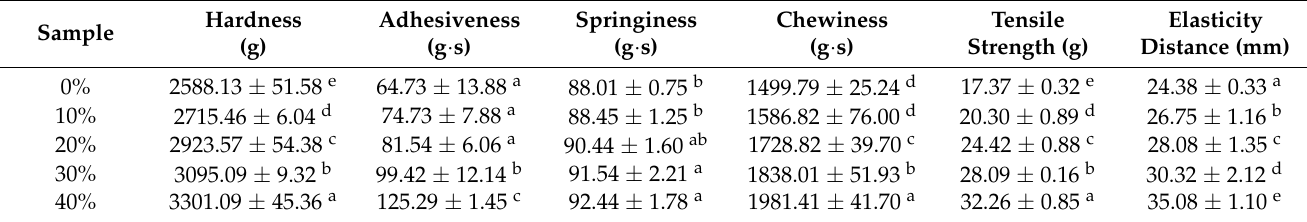
Table 7. Texture and tension properties of ginkgo biloba noodles.